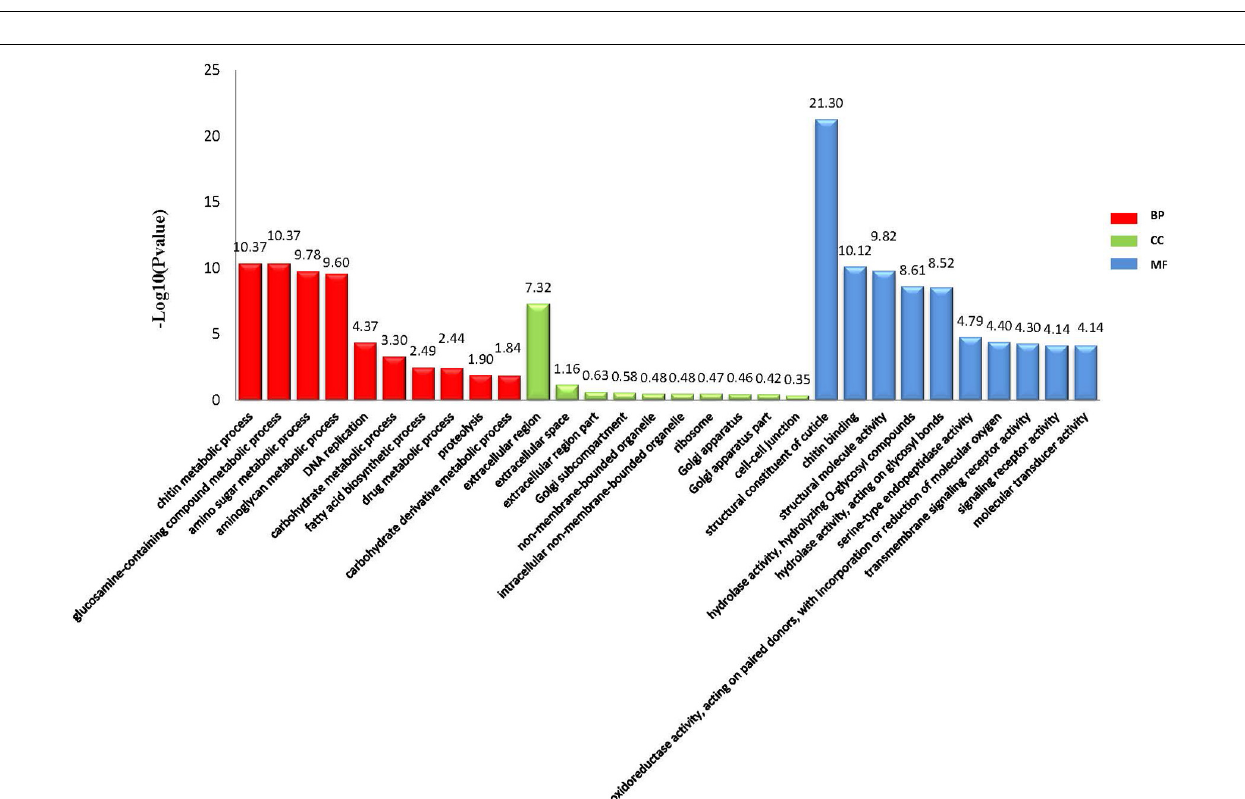
FIGURE 3 | GO enrichment analyses of significantly differentially expressed